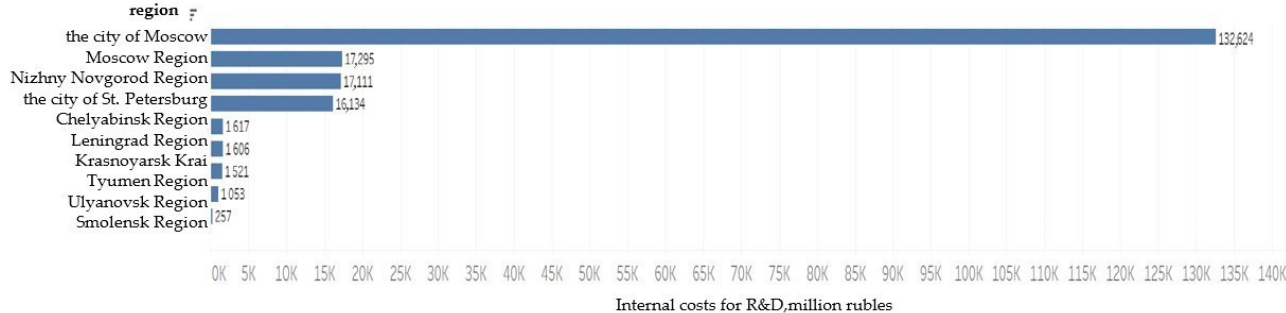
Figure 4. Size of incoming slacks according to the indicator of internal costs for R&D (vtz).